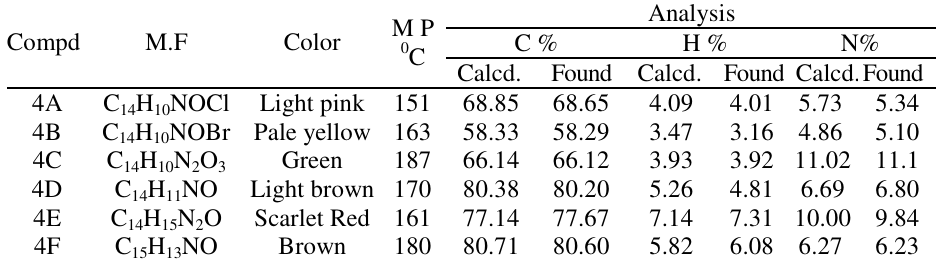
Table 1. Physical characteristics and elemental analysis of ketoazomethines